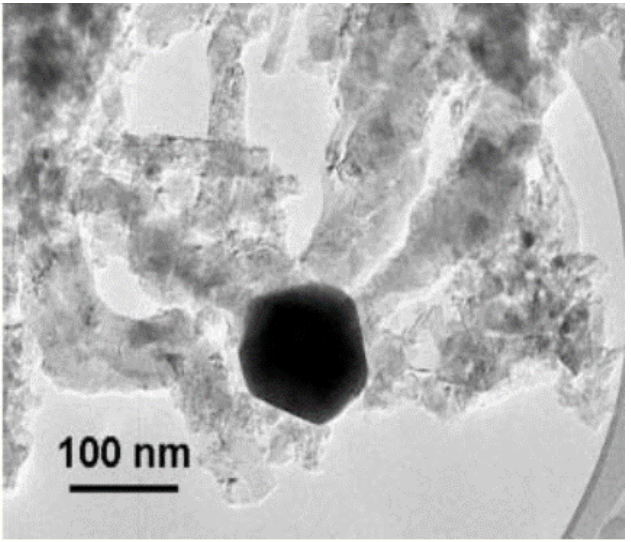
Figure 18. Typical octopus-shaped carbon nanofibers from the CDM process under SEM [73].